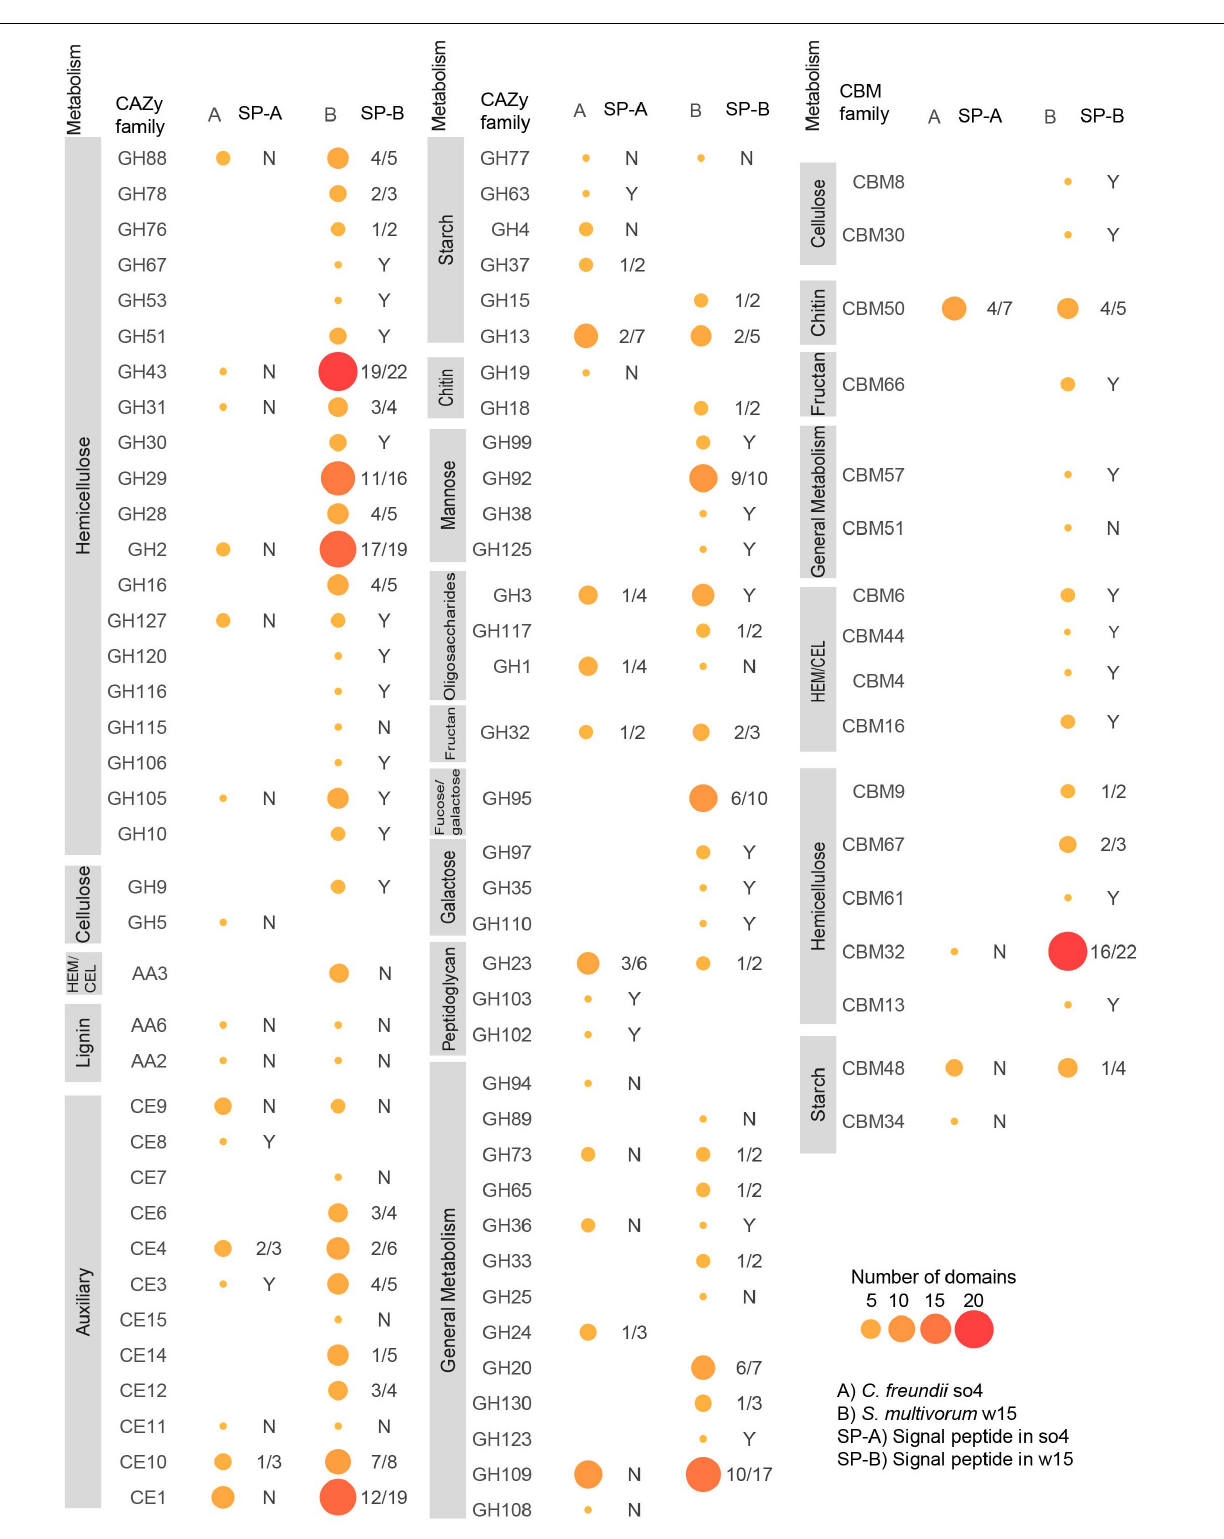
FIGURE 4 | Domain distributions in predicted proteins matching different CAZy and CBM families in C. freundii so4 (A) and S. multivorum w15 (B). Glycosyl hydrolases (GH), carbohydrate binding modules (CBM), auxiliary activity (AA), carbohydrate esterases (CE). HEM/CEL: enzymes active on cellulose and hemicellulose. SP-A/B is the rate of occurrence of signal peptides in the proteins found in each strain: Y = 100%, N = 0%, 4/5 means 4 out of 5 domains identified in this enzyme family have signal peptides. Sizes and colors of circles indicate the number of domains associated with each family.